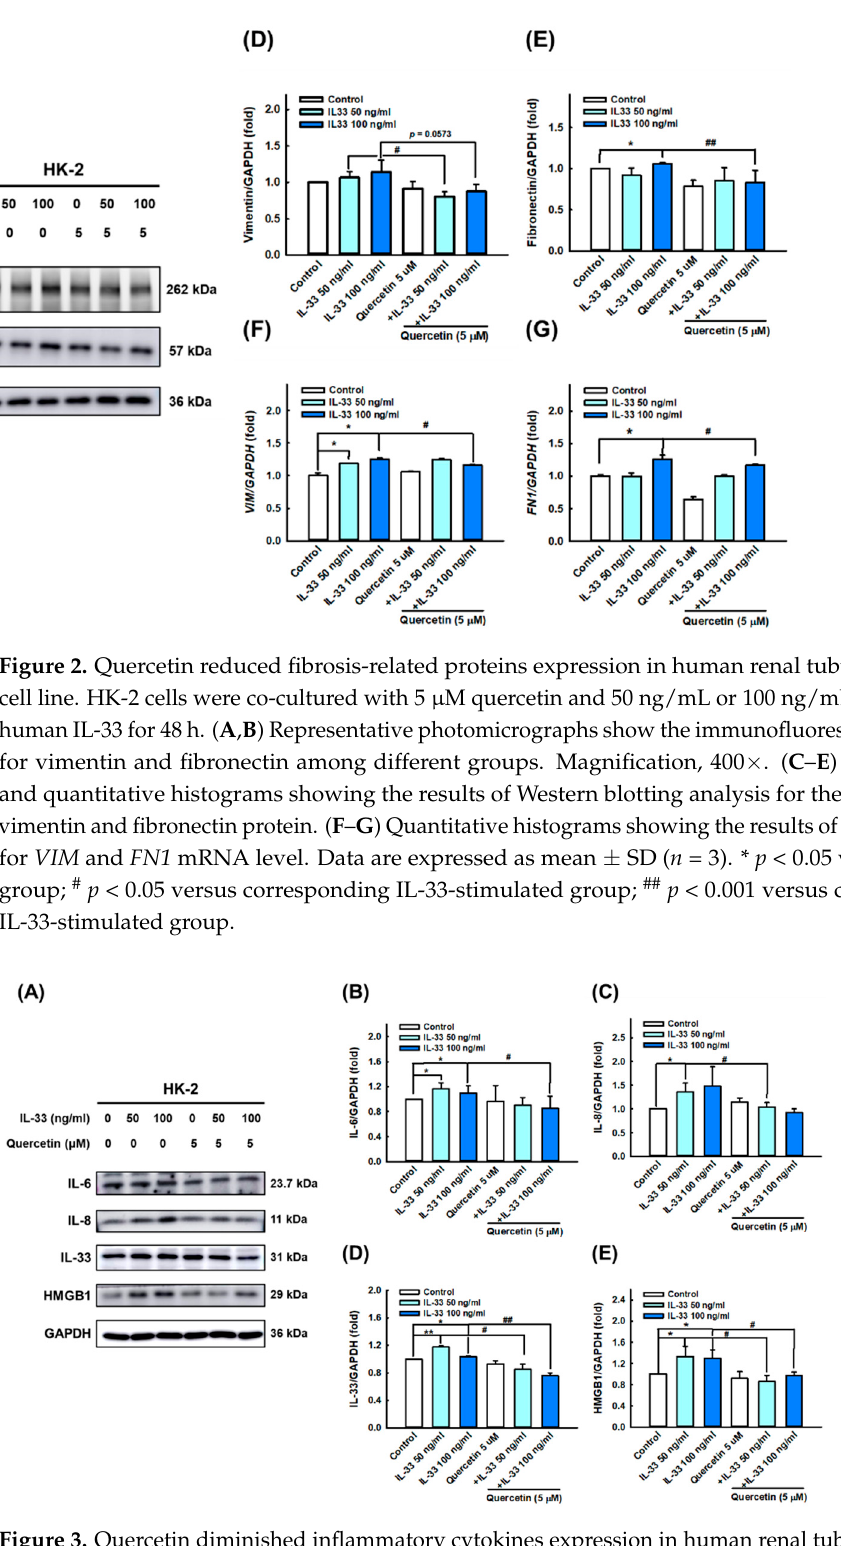
Figure 3. Quercetin diminished inflammatory cytokines expression in human renal tubular epithelial cell line. HK-2 cells were co-cultured with 5 μ M quercetin and 50 ng/mL or 100 ng/mL recombinant human IL-33 for 48 h. ( A – E ) Immunoblots and quantitative histograms showing the results of Western blotting analysis for the expression of IL-6, IL-8, IL-33, and HMGB1 proteins. Data are expressed as mean ± SD ( n = 3). * p < 0.05 versus control group; ** p < 0.001 versus control group; # p < 0.05 versus corresponding IL-33-stimulated group; ## p < 0.001 versus corresponding IL-33-stimulated group.